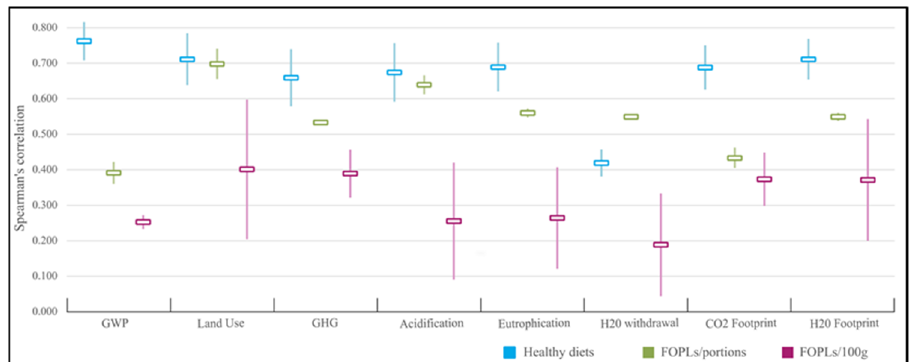
Figure 3. Average of Spearman’s correlations for healthy diets (in blue), FOPLs based on portions (in green), and FOPLs based on 100 g (in purple) (standard deviations are shown in lighter colors). Abbreviations: GWP = global warming potential; GHG = greenhouse gas emission.